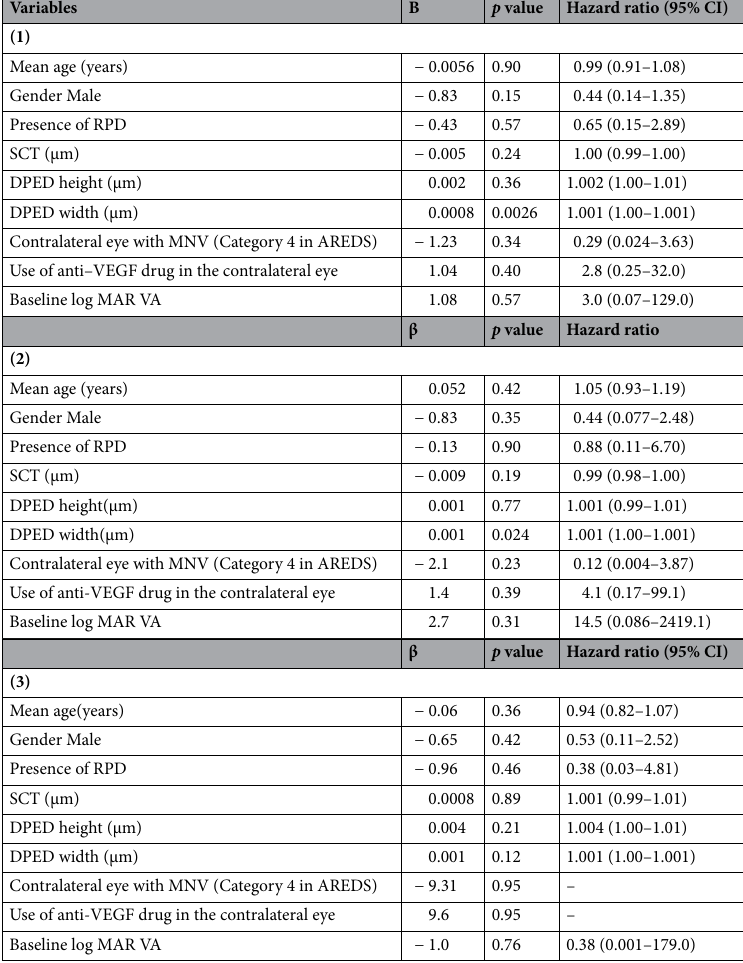
Table 2. Cox regression analysis associated with the development of (1) advanced age-related macular degeneration, (2) macular neovascularization, (3) geographic atrophy. CI: confidence interval, RPD: reticular